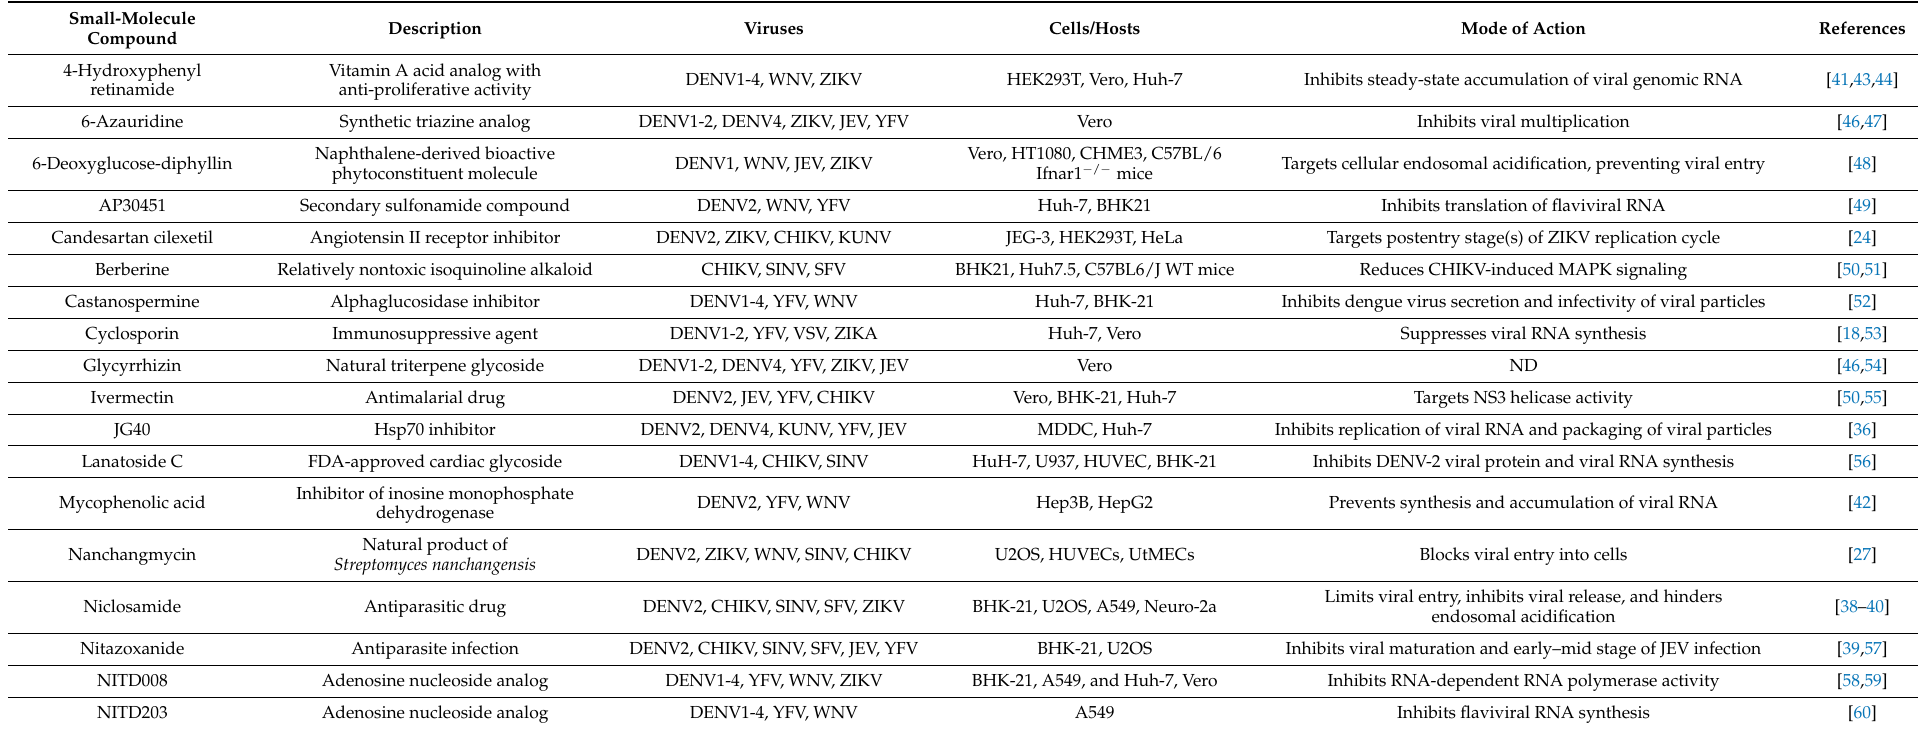
Table 1. Small-molecule compounds with a broad spectrum of antiarboviral activity in mammalian